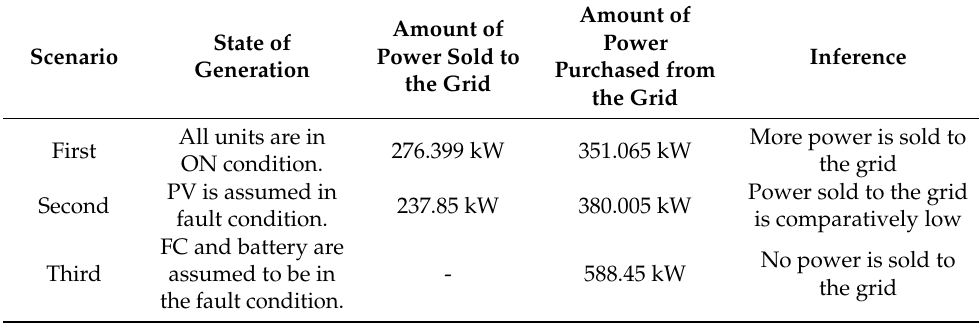
Table 10. Comparison of the three scenarios.